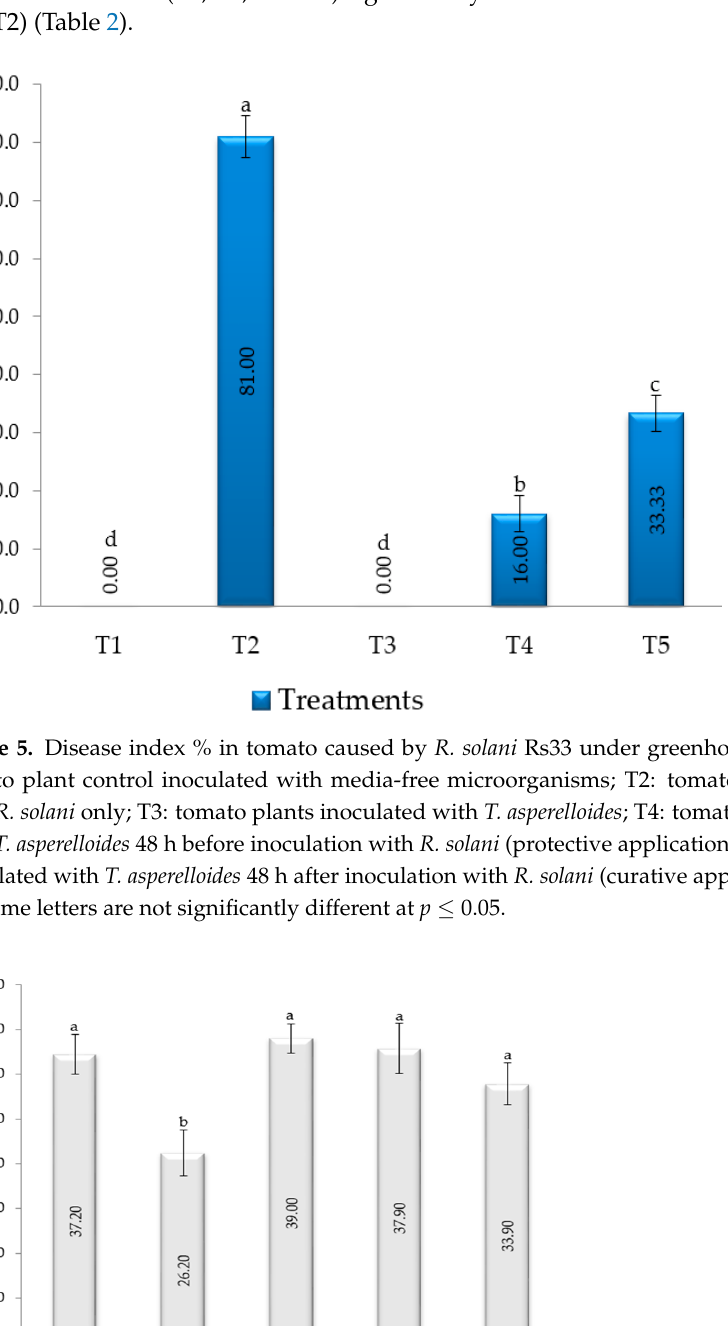
Figure 4. Effect of T. asperelloides Ta41 on R. solani Rs33 on tomato plants under controlled greenhouse conditions. T1: tomato plant control inoculated with media-free microorganisms; T2: tomato plants inoculated with R. solani only; T3: tomato plants inoculated with T. asperelloides ; T4: tomato plants inoculated with T. asperelloides 48 h before inoculation with R. solani (protective application); T5: tomato plants inoculated with T. asperelloides 48 h after inoculation with R. solani (curative application) .